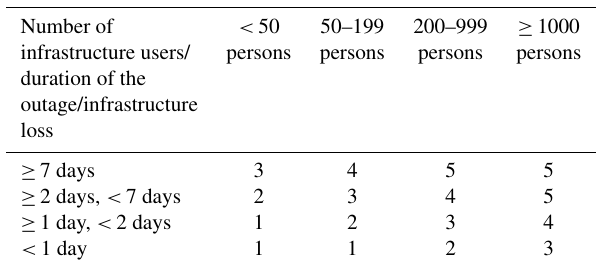
Table 3. Initial categorisation of consequence based on the number of infrastructure users and duration of the outage, simplified from the guidelines from the Norwegian Directorate for Civil Protection; DSB (2014). The consequence categories are indicative and should be adapted to the municipality’s size, i.e. in terms of number of